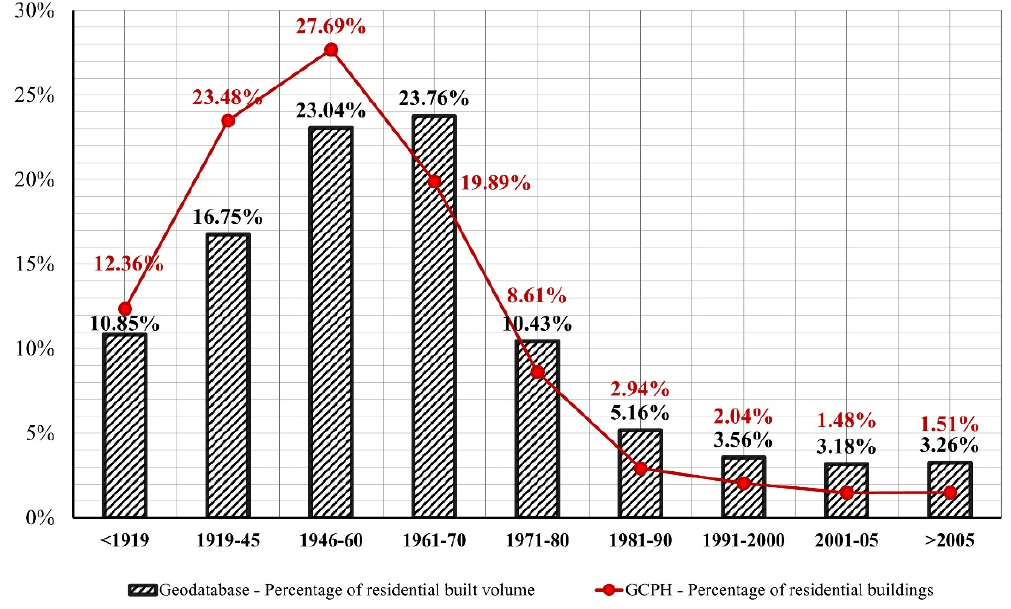
Figure 11. Comparison of distribution of residential stock by period of construction according to the Istat municipal data and the Geo-database elaborations.